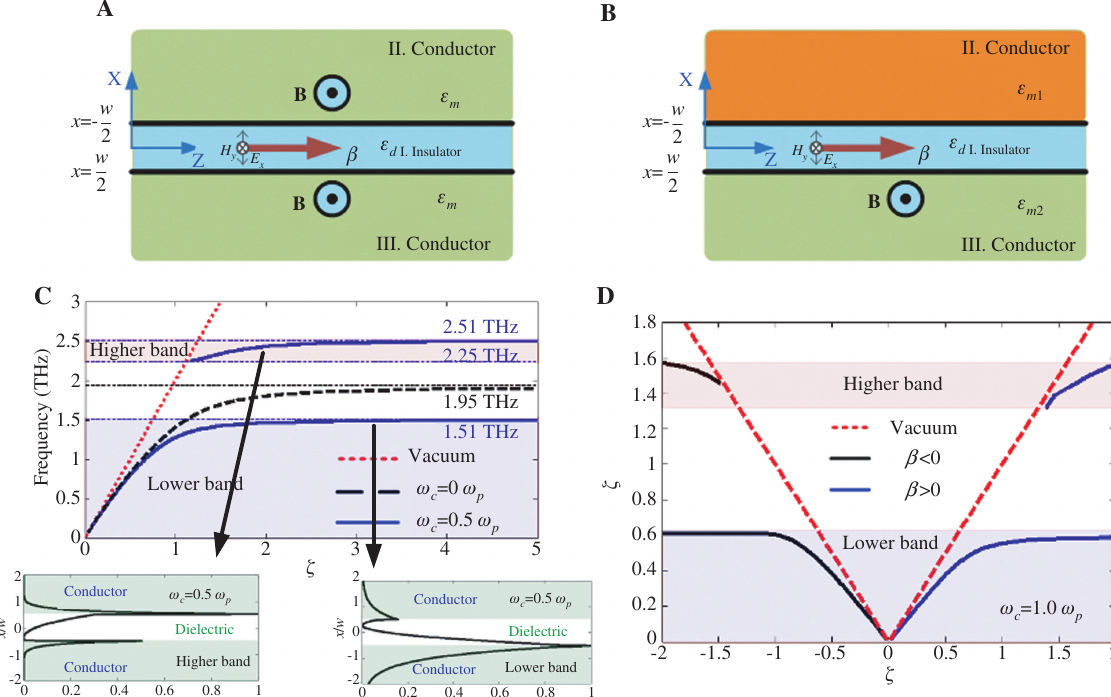
Figure 5: SMPs propagating in a slot waveguide. (A) Schematic of the symmetric structure. (B) Schematic of the asymmetric structure. (C) SMPs dispersion of the symmetric structure with ( ω field distribution in the slot waveguide for the higher and lower bands, respectively. (D) SMPs dispersion of the asymmetric structure with = ω ( ω ) the magnetic c p